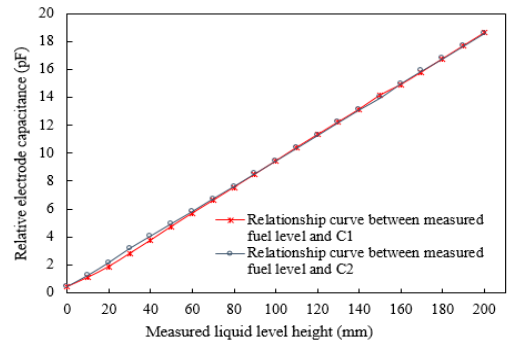
Figure 4. Relationship between liquid level and output capacitance.